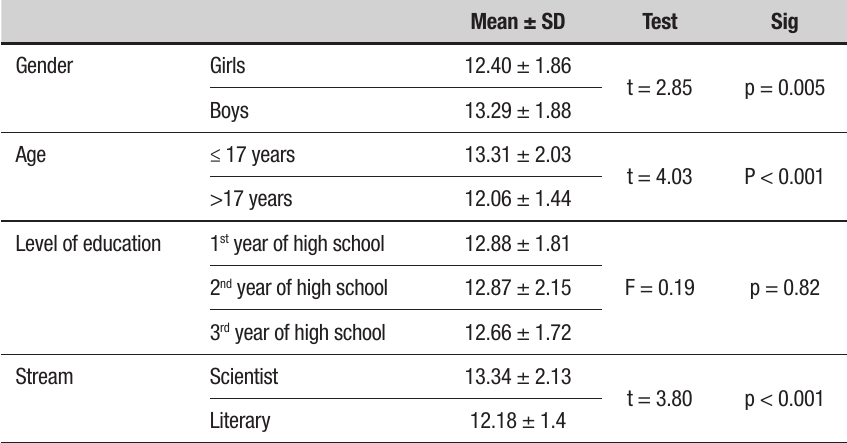
Table 3. Means for school performance by gender, age, level of education and stream.